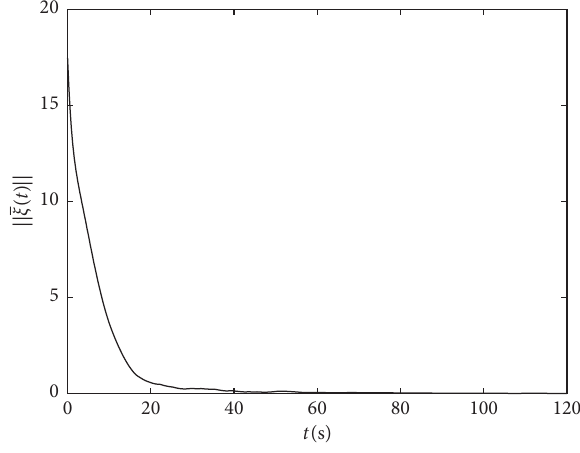
Figure 7: Evolution of ‖ ξ ( t )‖ when τ � 0.